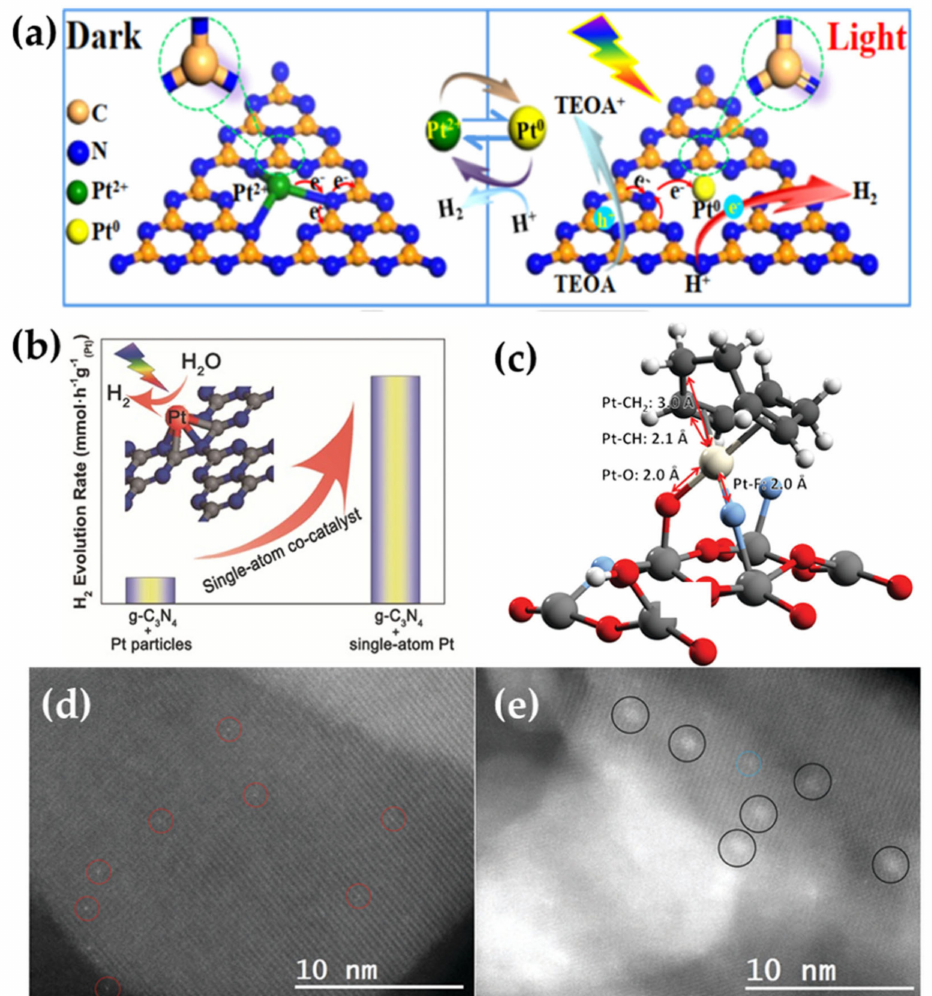
Figure 8. ( a ) Illustration of the charge transfer and bond variation on S-Pt-C 3 N 4 catalysts for photocatalytic hydrogen evolution [99]; ( b ) Photocatalytic activity comparison of g-C 3 N 4 with Pt nanoparticles and single atoms, respectively. Inside is the structure model of Pt-C 3 N 4 [98]; ( c ) O–Pt–F DFT-optimized structure, used as the initial model for EXAFS fitting; ( d , e ) HAADF-HRSTEM images of the 0.5%Pt GR :TiO 2 [100]; ( d ) and 0.5%Pt NP :TiO 2 ( e ). Single atoms are denoted by red circles, clusters by blue circles, and nanoparticles by black circles